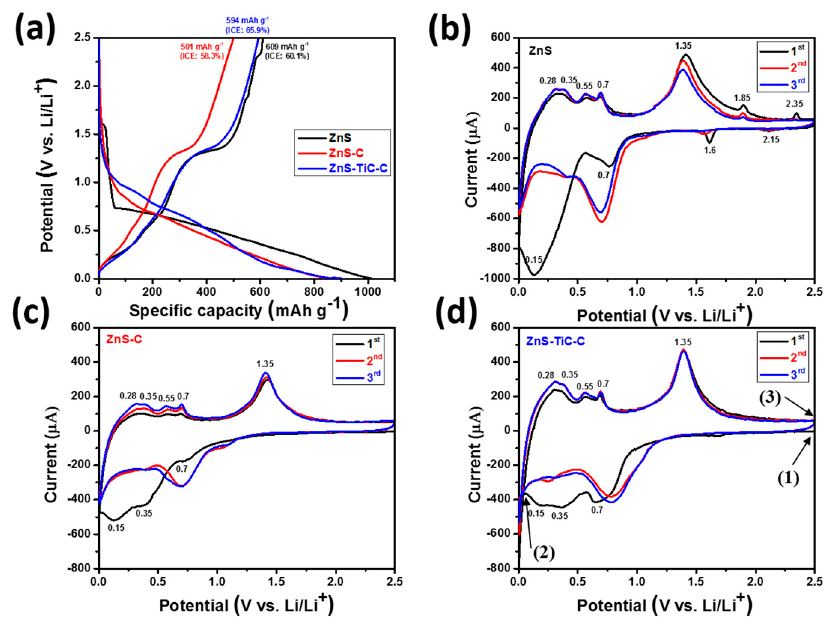
Figure 4. ( a ) Initial charge / discharge profiles and ( b – d ) cyclic voltammogram (CV) curves of the ZnS, ZnS-C, and ZnS-TiC-C